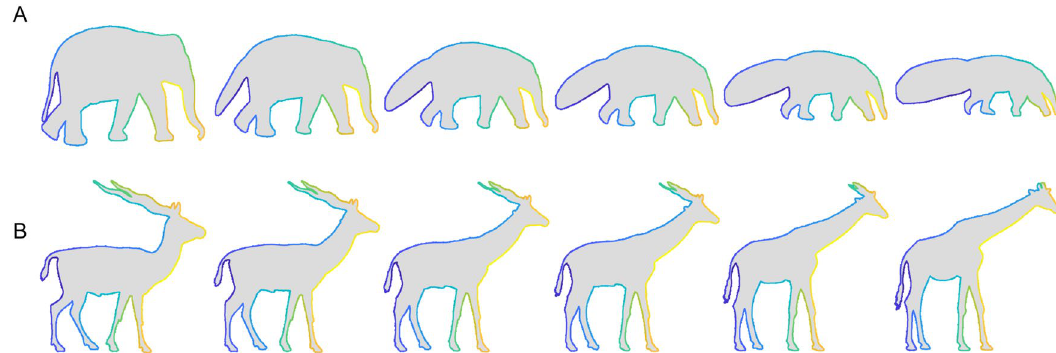
Figure 13. Examples of morphing based on the correspondence predictions of the semantic organization model for ( A ) Elephant–Anteater and ( B ) Antelope–Giraffe pairs of Experiment 1. Morphs are based on correspondences predicted by the semantic organization model with linear interpolation of in-between contour segments. Contours are colored according to their correspondence across morph levels. To avoid